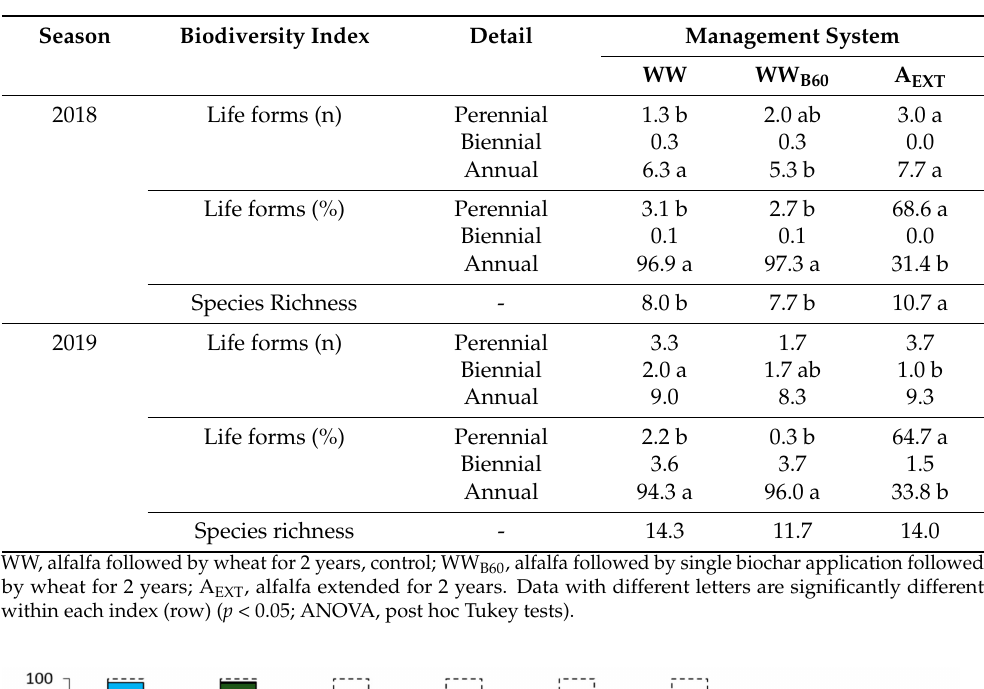
Table 1. Plant diversity as influenced by the management systems across the two seasons.